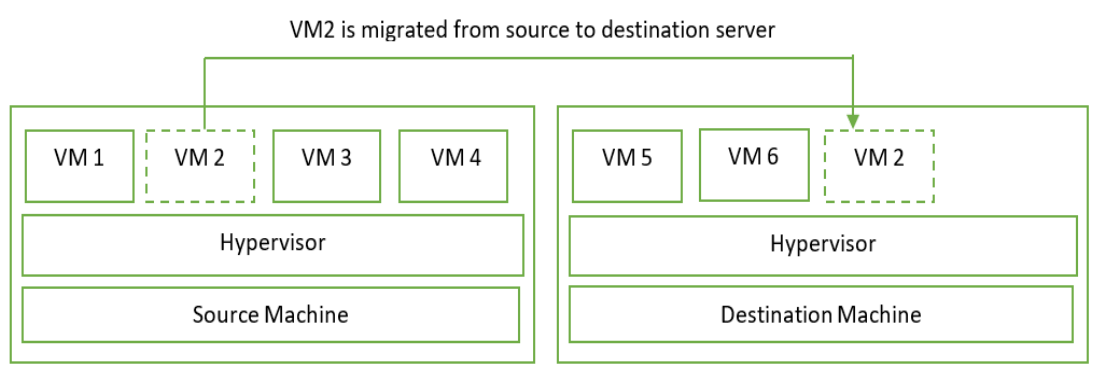
Figure 1. VM migration scenario of over-utilized and under-utilized servers.